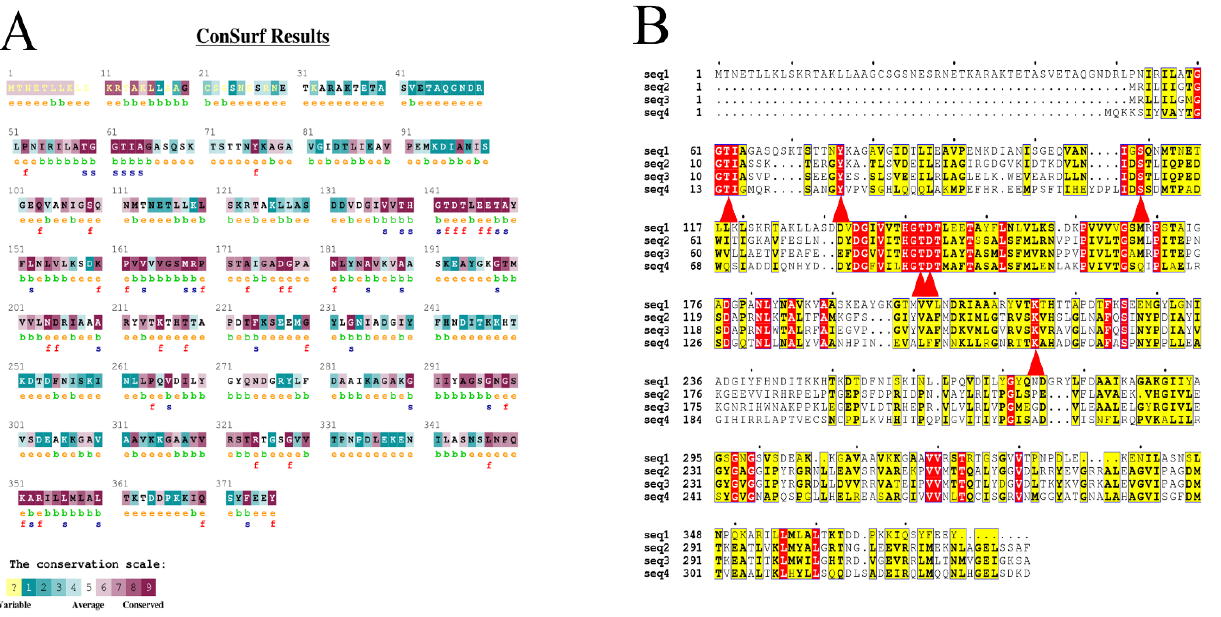
Figure 1. ( A ) Conservation analysis of BLASNase by ConSurf. Cyan-to-purple palette corresponds to unconservative (grade 1)-to-conserved (grade 9) scores. ( B ) Sequence alignment of BLASNase and other high enzyme activity ASNases. The active sites are marked by a red triangle below. Seq 1, BLASNase; seq 2, Thermococcus gammatolerans EJ3 ASNase (WP_015859055.1); seq 3, Pyrococcus yayanosii ASNase (WP_013906452.1); seq 4, Pectobacterium carotovorum MTCC 1428 ASNase (AFA36648.1).